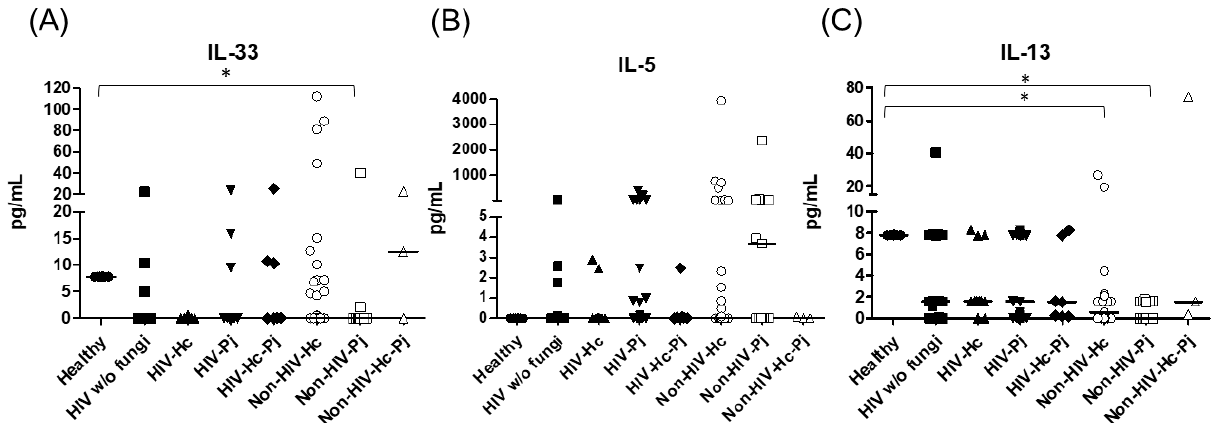
Figure 5. Determination of cytokines of the IL-17/IL-23 axis. IL-6, IL-17A, and IL-23 were detected by a cytometric bead assay in the BAL samples of hospitalized patients; results were obtained in pg/mL. Median values are shown for ( A ) Il-6, ( B ) IL-17A, and ( C ) IL-23. * p < 0.05.